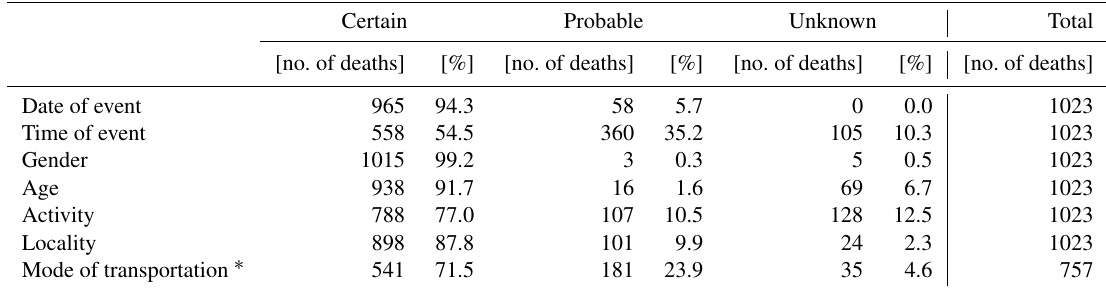
Table 3. Quality of the data describing the circumstances of fatal natural hazard events and the victims (certain means that information regarding this variable is fully reliable; probable means information regarding this variable was deduced but is very probable; unknown means that no information was available).